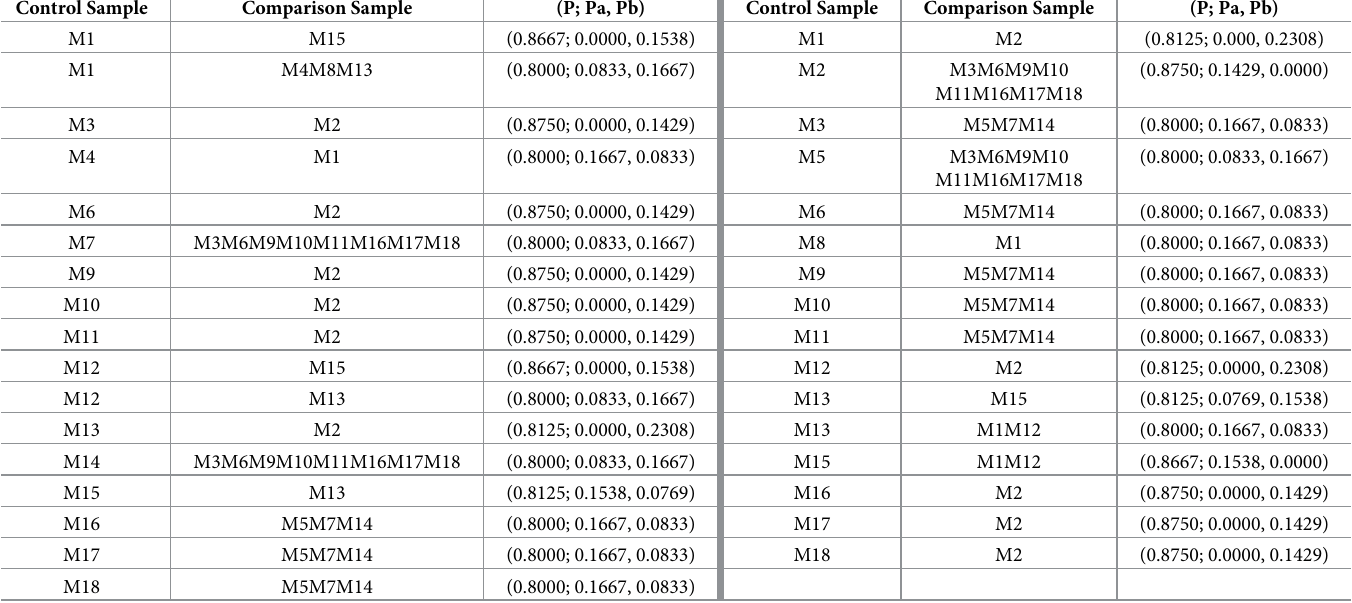
Table 7. The sequence with high common peak rate and high variation peak rate (Group C).